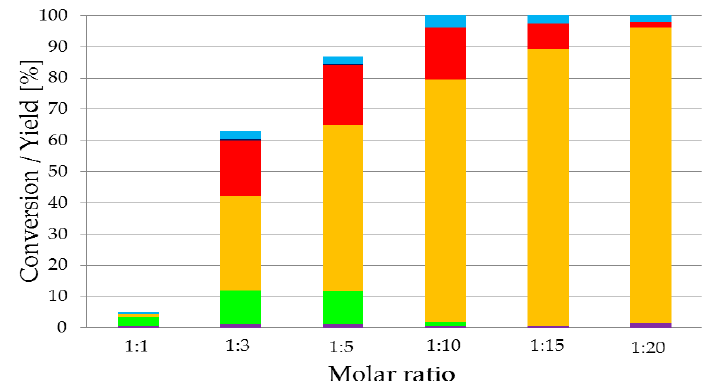
Figure 5. The yields of individual products and total conversion for the reaction of 1 mol/L 1,2-propanediol and 30% H 2 O 2 /H 2 O. Reaction conditions: 20 mg 0.1% Au/SiO 2 , 85 °C, 20 h, 200 rpm, 0.3 moL/L concentration 1,2-propanediol in reaction mixture after mixing the reagents. Particular colors at chart refer to: ■ acetone (ACNE), ■ 1-hydroxyacetone (HYNE), ■ acetic acid (AA), ■ formic acid (FA), ■ acetaldehyde (ACDE) ■ other products (OS). The experiments were conducted for the same volume of reagents (0.5 mL alcohol with 1.0 mL H 2 O 2 /H 2 O solution with increasing molar ratio of oxidant) in procedure described in Section 2.3.